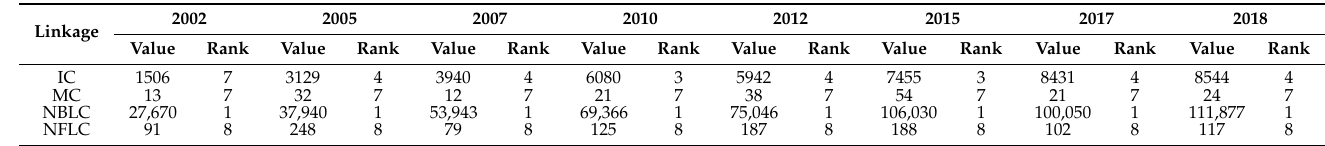
Table 1. The four components of energy consumption linkages in construction sector, 2002–2018 (10 4 tce).